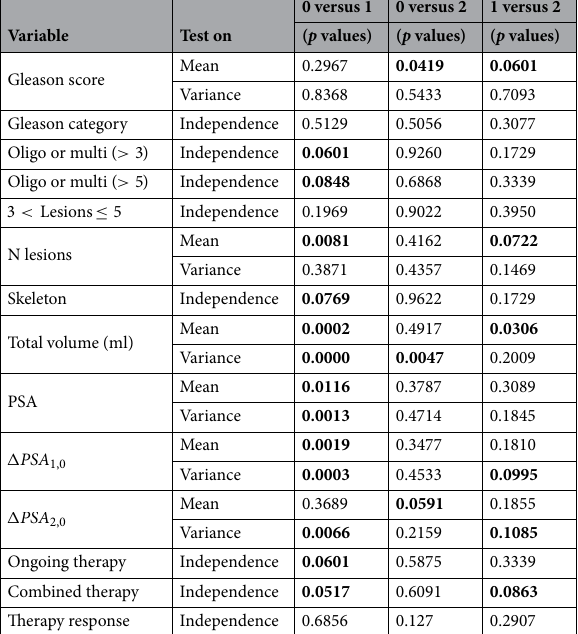
valid tool for prognosis and treatments in advanced stages of metastatic prostate cancer 26 . Moreover, PSA values after cytotoxic regimens has been shown to predict survival. Particularly, the decrease in PSA levels is associated to therapy response in soft tissue lesions and thus could be intended as a proxy of therapy outcome 27 . Accord- ingly, we recorded PSA levels before the therapy (PSA0), right after the first line of therapy (PSA1) and at the end of the follow up (PSA2). Delta-PSA levels were computed between PSA1-PSA0 and PSA2-PSA0 as proxies of cancer progression. In the following, they will be referred as PSA, (cid:31) PSA 1,0 and (cid:31) PSA 2,0 . Table 1 and Fig. 3 elucidate the results. The profile of the blue and green groups are very similar for what PSA ( p m / d = 0.3787 , p var = 0.4714 ) and (cid:31) PSA 1,0 ( p m / d = 0.3477 , p var = 0.4533 ) are concerned, with a very limited range of values concentrated around zero. Different trends are exhibited by the blue and green curves of the (cid:31) PSA 2,0 ( p m / d = 0.0591 ), where the difference could support the hypothesis of different cancer evolution starting from similar baseline assessments. Yet, they present similar variance ( p var = 0.2159 ). The orange group, on the other hand, presents wider ranges and higher intra-group heterogeneity. In particular, orange PSA is sig- nificantly higher than the blue group with a much more spread distribution ( p m / d = 0.0116 ; p var = 0.0013 ) yet no statistical difference with the green groups is confirmed ( p m / d = 0.3089 ; p var = 0.1845 ); orange (cid:31) PSA 1,0 is significantly lower than the blue group ( p m / d = 0.0019 ) but not than the green one ( p m / d = 0.1810 ), however its distribution appears more spread and inhomogeneous, covering both the negative and the positive axis, in both cases ( p var = 0.0003 ; p var = 0.0995 ). The (cid:31) PSA 2,0 of the orange group does not vary from the one of the blue group ( p m / d = 0.3689 ). However, it shows a higher variance than the other, suggesting a heterogeneous long- term tumor prognosis ( p var = 0.0066 ). Also, the orange group and the green group do not differ significantly in their average ( p m / d = 0.1855 ) but their variances reveal a mild divergence in terms of distribution kurtosis ( p var = 0.1085 ).